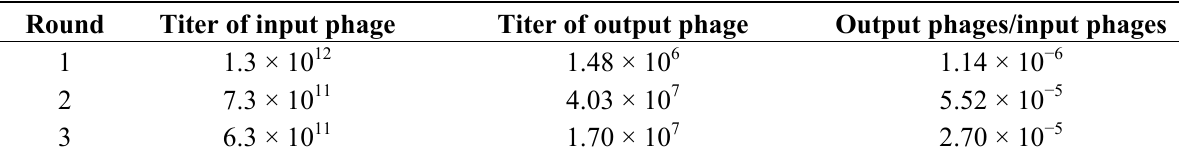
Table 1. Enrichment of specific phages during subsequent rounds of